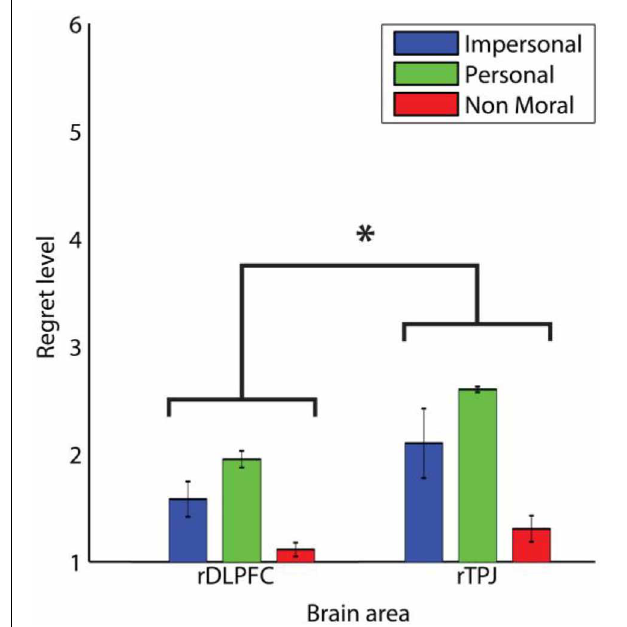
FIGURE 4 | Regret levels in TMS experiment. The three different moral conditions are grouped over the four different time points of TMS application over the right DLPFC and right TPJ. Error bars indicate one standard error from the mean on both sides. ∗ Indicates a significant difference between the DLPFC and TPJ, p < 0 .